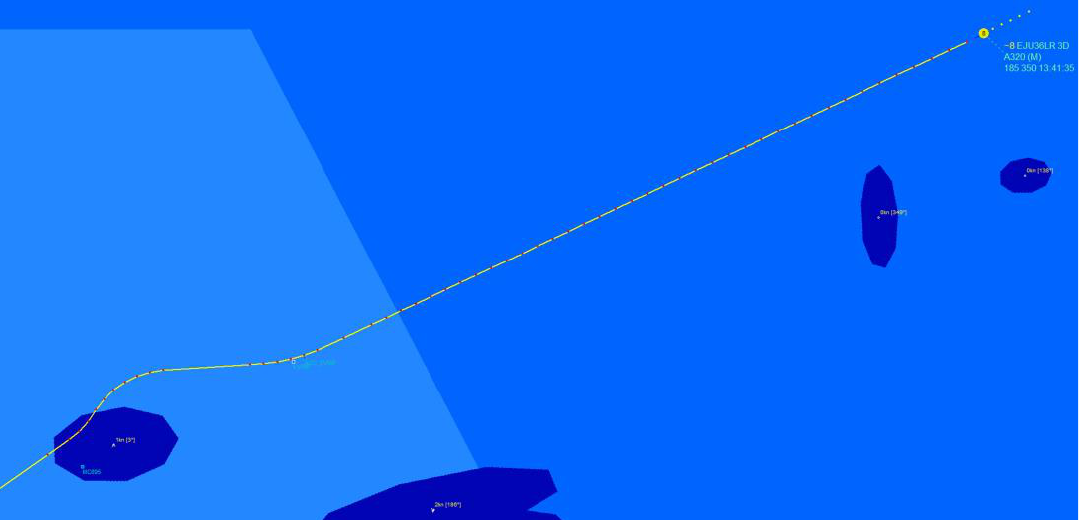
Figure 20. Route calculation for the aircraft EJU36LR approaching MXP from the northeast through a loose group of convective areas. Currently, this route is still blocked by a convective cell; however, based on the forecast, the AMAN knows that the route will be clear by the time the aircraft arrives. MXP traffic mix from 11 May 2019 with weather from 6 August 2019 and the RaNDeVIL nowcast model.